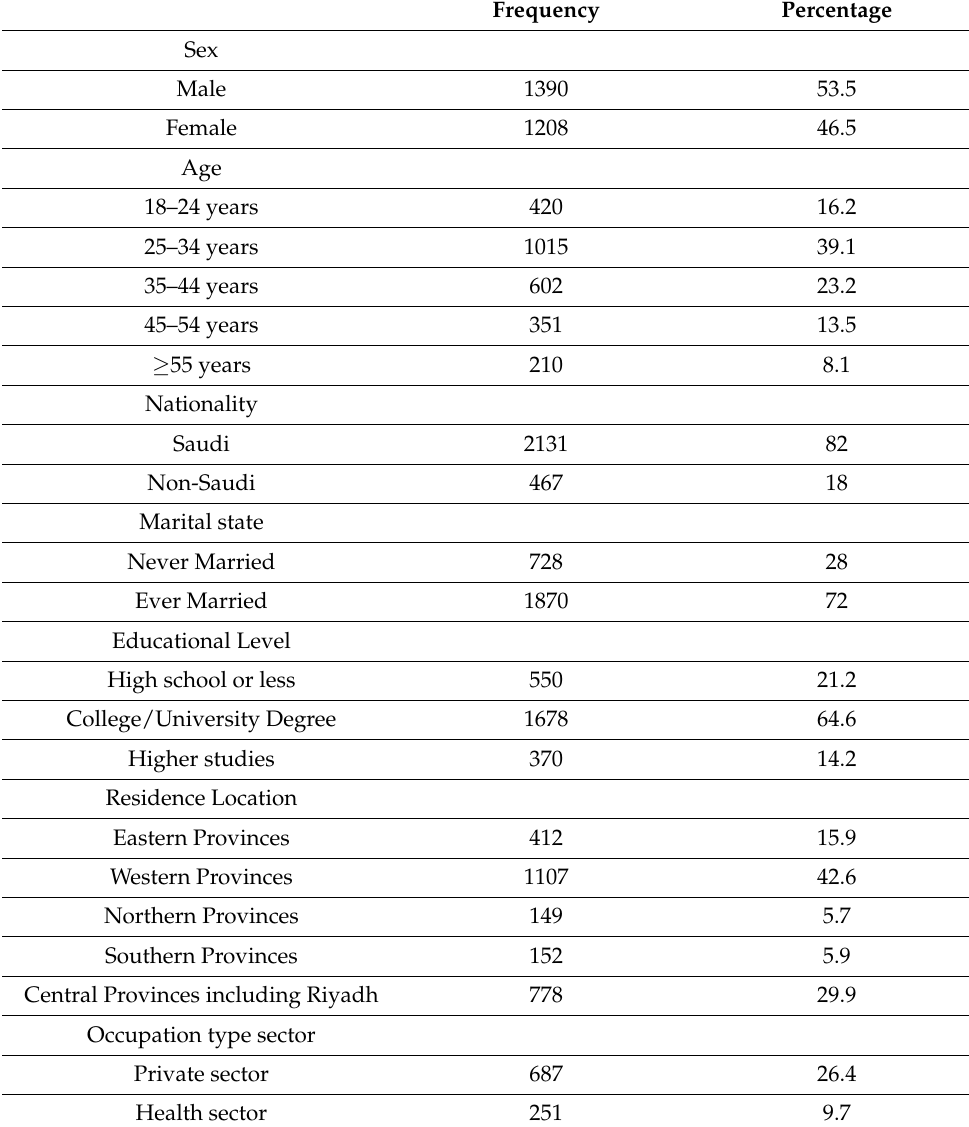
Table 1. Descriptive analysis of the respondent’s sociodemographic characteristics. n =